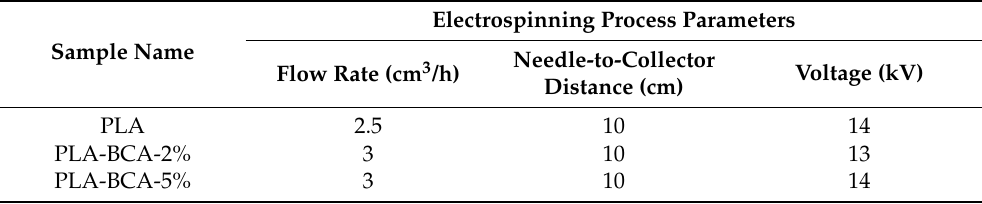
Table 1. Samples and process parameters of